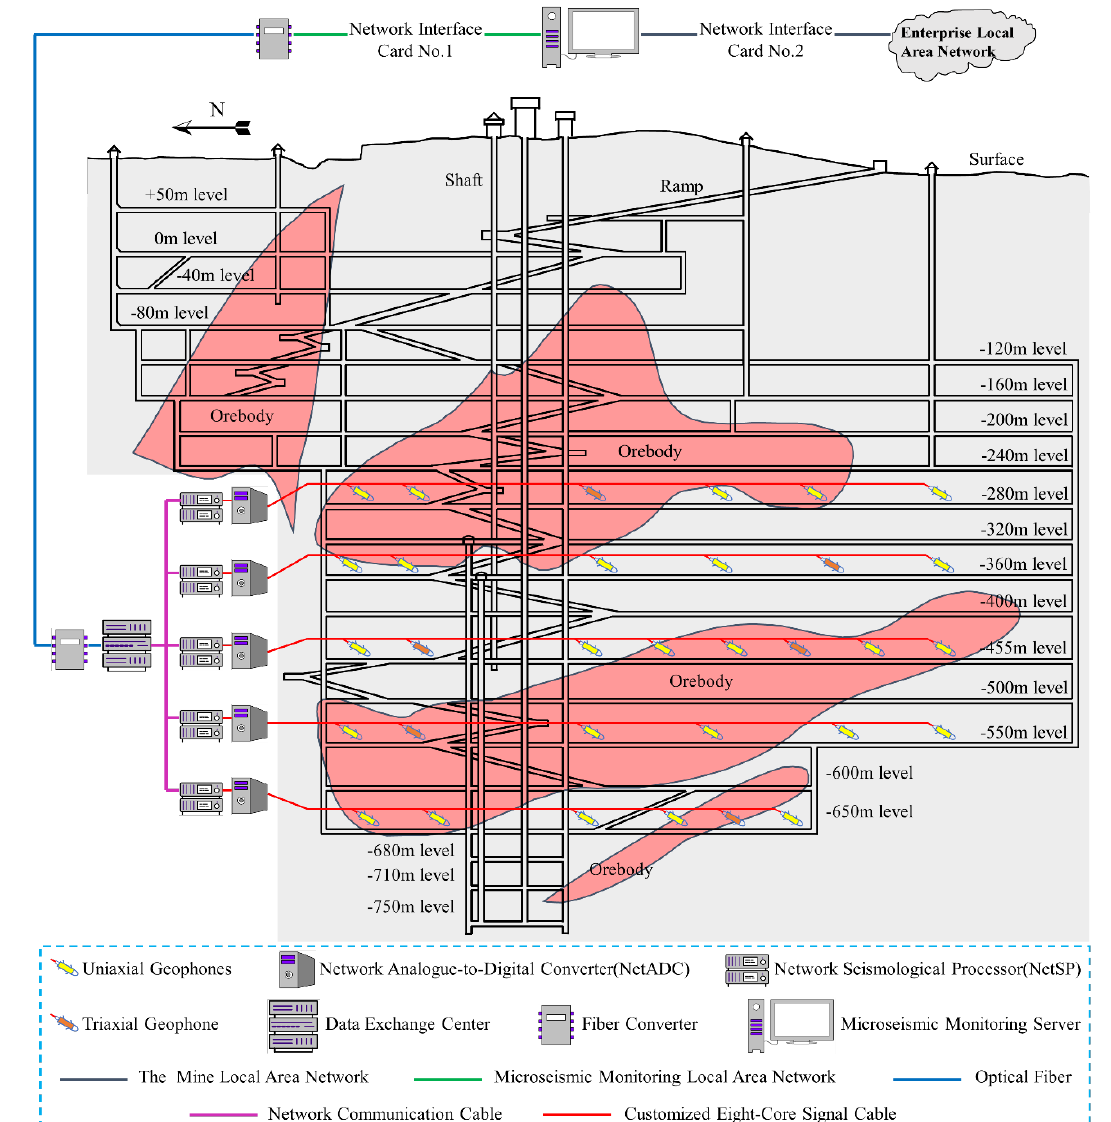
Figure 2. The IMS system in Fankou Lead-Zinc Mine.